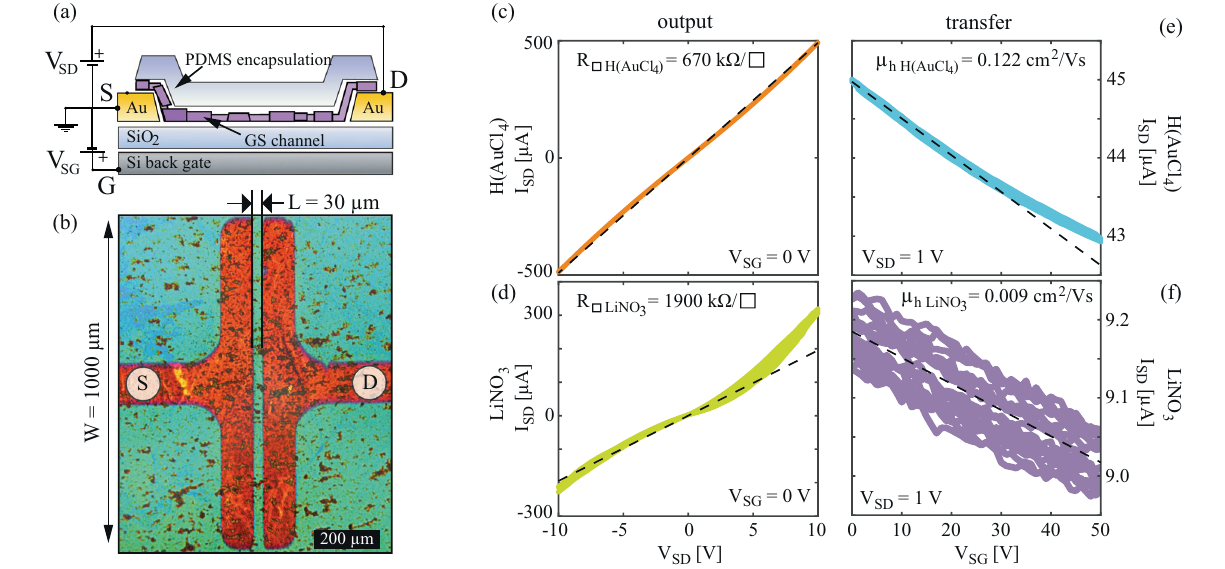
Figure 6. ( a ) Schematic cross-section of the bottom-contacted back-gated FET devices, also indicating electrical connections. ( b ) Optical microscopy image of one of the devices, without PDMS capping (for clarity). LBA GS film covers the entire sample surface. ( c , d ) Output curves of H(AuCl 4 ) and LiNO 3 doped samples, and ( e,f ) transfer curves of H(AuCl 4 ) and LiNO 3 doped samples, respectively. Dashed lines represent least squares linear fits (to selected regions) that were used to extract sheet resistance and linear